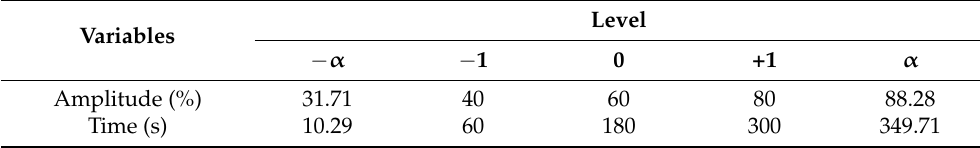
Table 1. Coded experimental level of each variable